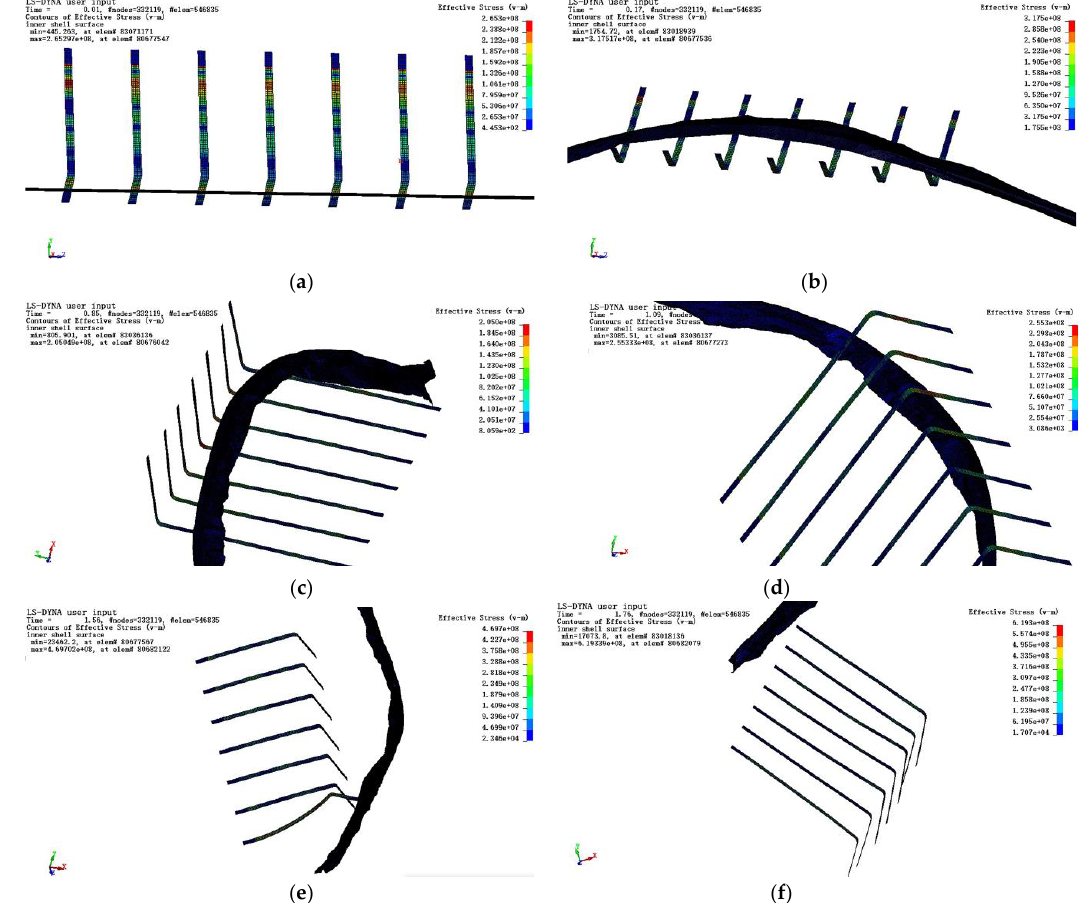
Figure 11. Effective stress distribution of elastic teeth at different times. ( a ) represents the effective stress distribution of the elastic teeth at T=0.01s; ( b ) represents the effective stress distribution of the elastic teeth at T=0.17s; ( c ) represents the effective stress distribution of the elastic teeth at T=0.85s; ( d ) represents the effective stress distribution of the elastic teeth at T=1.09s ;€ represents the effective stress distribution of the elastic teeth at T=1.56s; and ( f ) represents the effective stress distribution of the elastic teeth at T=1.76s. As can be seen from Figure 11(a), at the beginning of the picking motion, the inclined surface of the front end of the elastic teeth began to contact and cradle the sugarcane leaf, and the sugarcane leaf was elastically deformed. The sugarcane leaf exerted a reaction force on the elastic teeth, and the effective stress of the elastic teeth increased, among which the effective stress at the root of the elastic teeth increased more than at other parts of the elastic teeth.